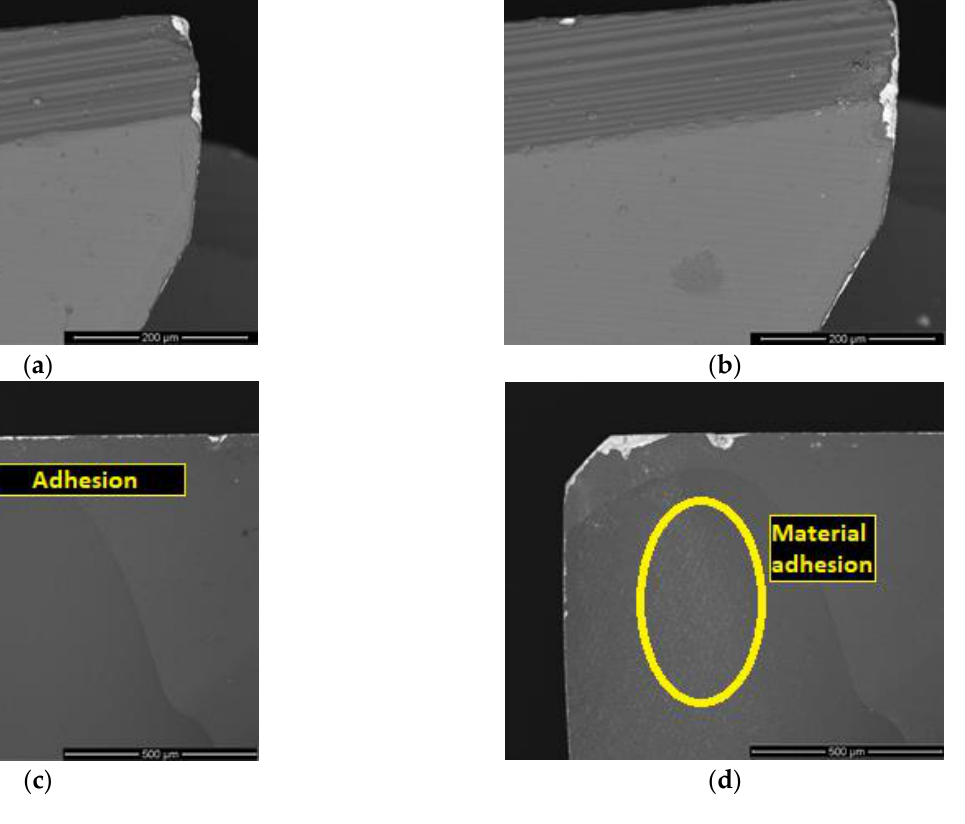
Figure 7. Clearance face, with a 500× magnification, of the T1L2F75 ( a ) and T1L2F125 ( b ) tools, and rake face, with a 500× magnification, of the T1L2F75 ( c ) and T1L2F125 ( d ) tools.